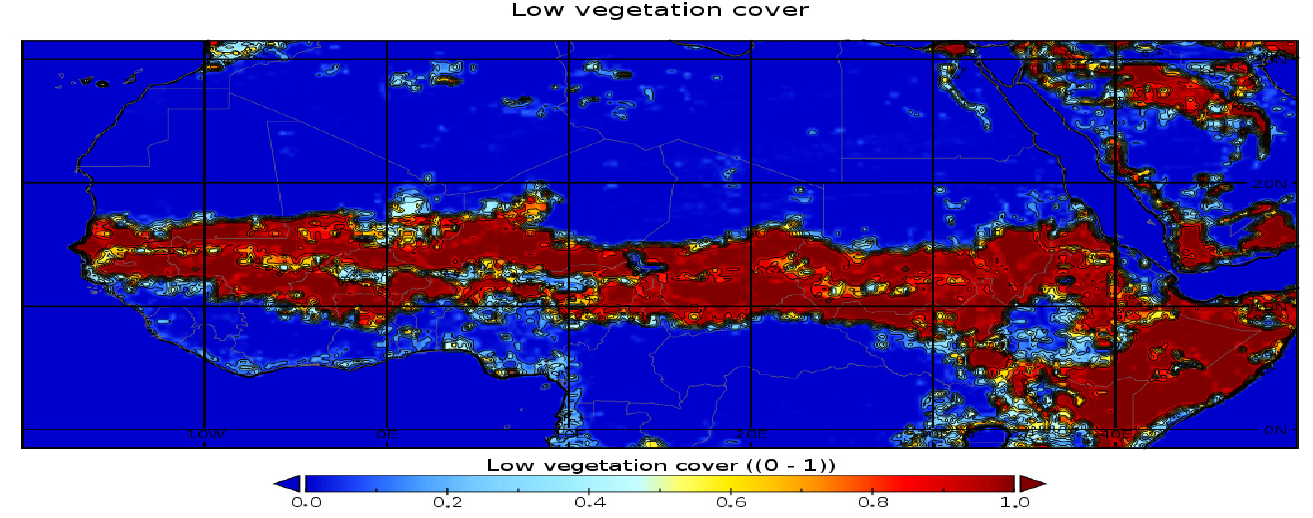
Figure 12. Climatology of lowland land cover evolution (4D-Var ERA5), 1979 to 2008 with a resolution of 0.5 × 0.5 degrees. Data from the ERA5 platform. Table 2. Summary of soil types in the 10–20 African